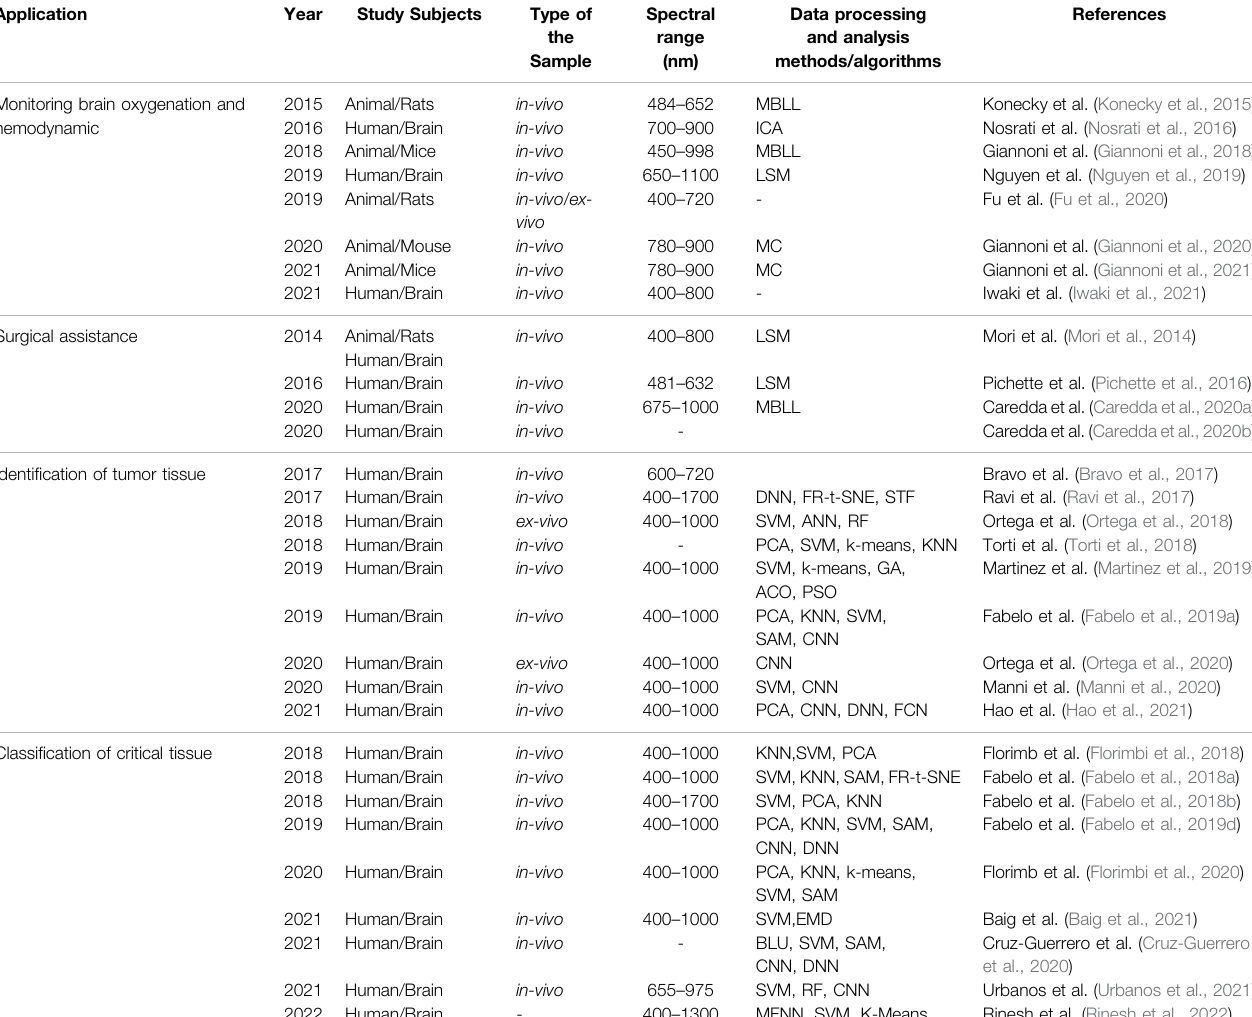
TABLE.1 | Summary of HSI applications in cerebral